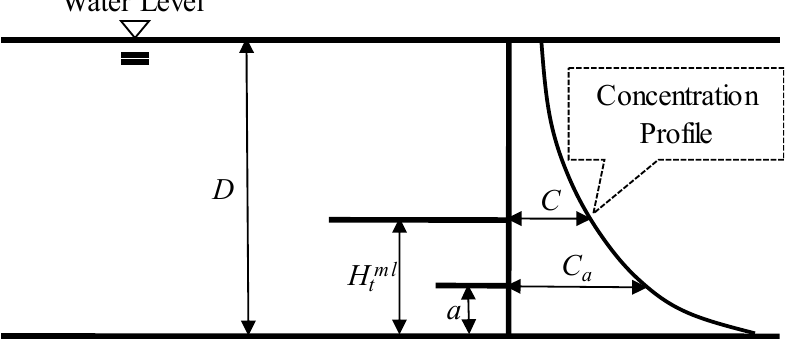
Figure 5. Concentration profile of dam face.